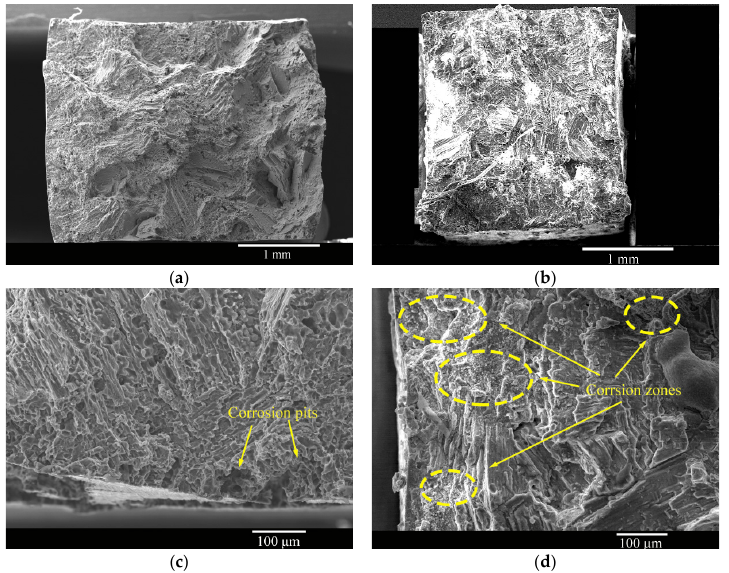
Figure 11. Fracture morphologies of the ( a , c ) as-cast and ( b , d ) solid-solution-treated AM50 magne- sium alloy samples SSRT tested in 3.5% NaCl solution. The fracture morphologies of the as-cast and solid-solution-treated AM50 Mg alloy samples SSRT tested after pre-immersion in 3.5% NaCl solution for 24 h are shown in Figure 12. Almost no corrosion traces were observed in the middle of both samples. Five corrosion areas existed at the edges of the as-cast sample (Figure 12a). In a magni fi ed im- age (Figure 12c), cracks were observed in the corroded areas, and river-like pa tt erns and cleavage steps were observed near the middle of the sample. Four large corrosion areas were observed in the solid-solution-treated sample (Figure 12b). Moreover, cracks and smaller cleavage steps were observed. These characteristics indicated that corrosion did not change the mechanism of tensile fracture of the AM50 Mg alloy, which was still quasi- cleavage. From the fracture morphologies, stress concentration at the bo tt om of surface corrosion pits was the direct reason for fracture failure.